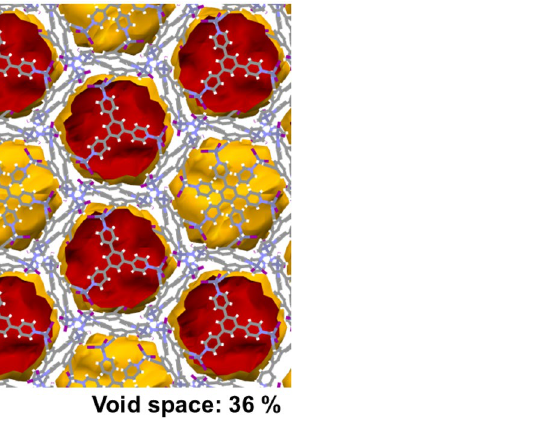
Figure 4. Picture showing the isolated voids in 1 . The nitrobenzene guest molecules were removed manually to show the available space occupied by the guest molecules, which amounted to 36% of the total cell volume. X-ray data measured at room temperature. Color code: Carbon: gray; Nitrogen: blue; Hydrogen: white; Zinc: gray; Iodide: